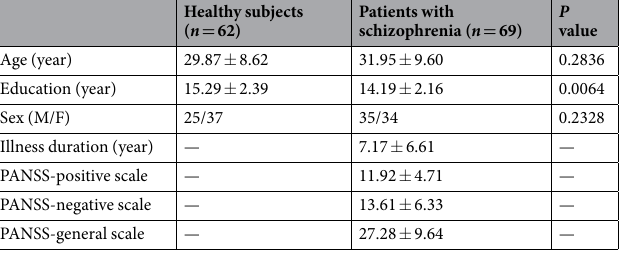
Table 1. Demographic information for the participants. PANSS, Positive and Negative Syndrome